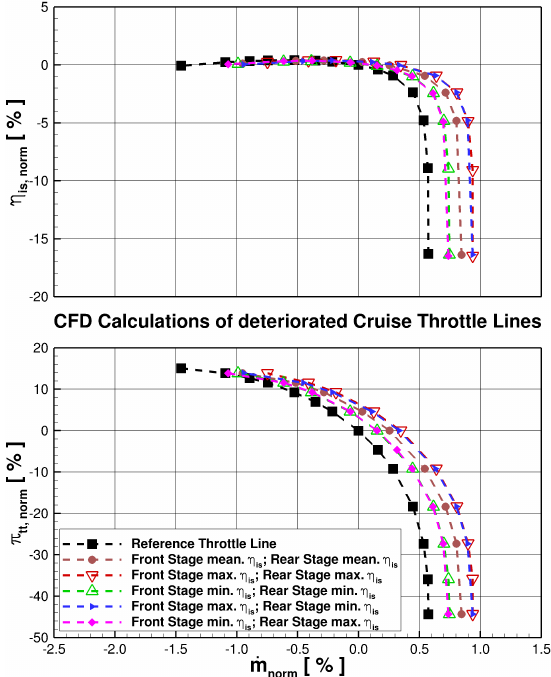
Figure 3. Computational fluid dynamic (CFD) calculations of different deterioration combinations in the high pressure compressor